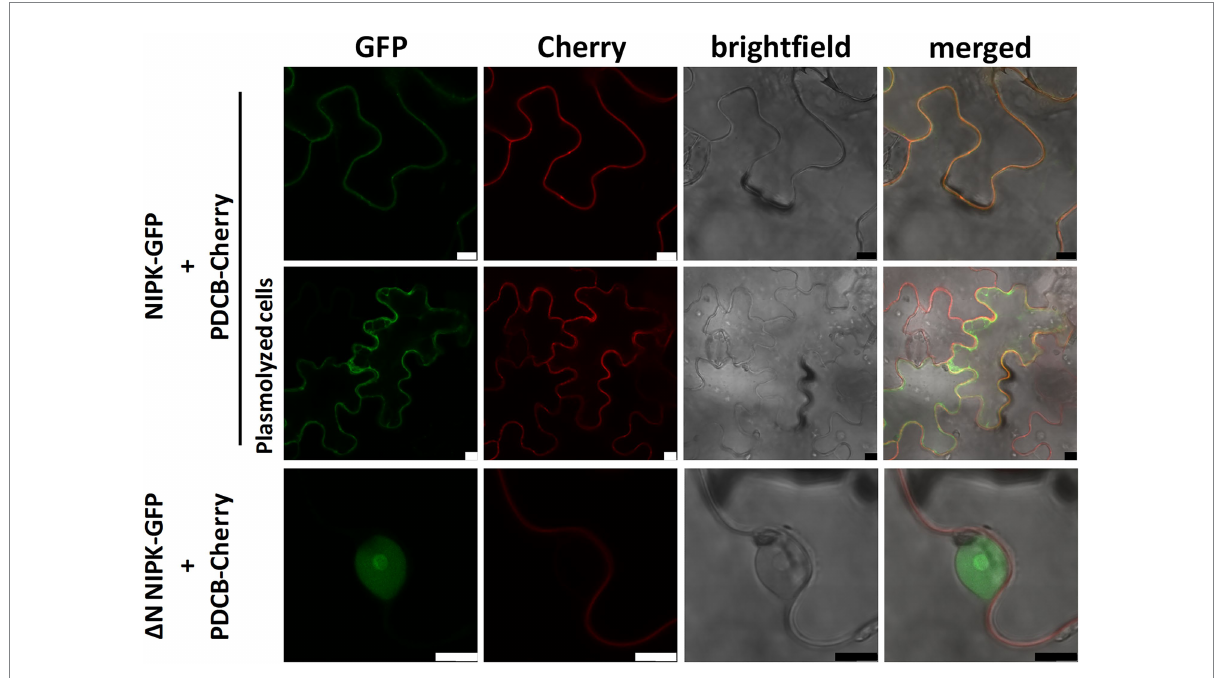
FIGURE 3 Subcellular localization of NIPK. Nicotiana benthamiana epidermal leaf cells co-expressing NIPK-GFP together with PDCB-Cherry as a plasma membrane marker in non-plasmolyzed or plasmolyzed cells (upper and middle panels, respectively). Lower panels show the subcellular localization of GFP- ∆ N NIPK and the plasma membrane marker in non-plasmolyzed cells. Confocal laser microscopy images of the GFP and Cherry fluorescence, bright field, and merged are shown. Scale bar: 10 μ m.